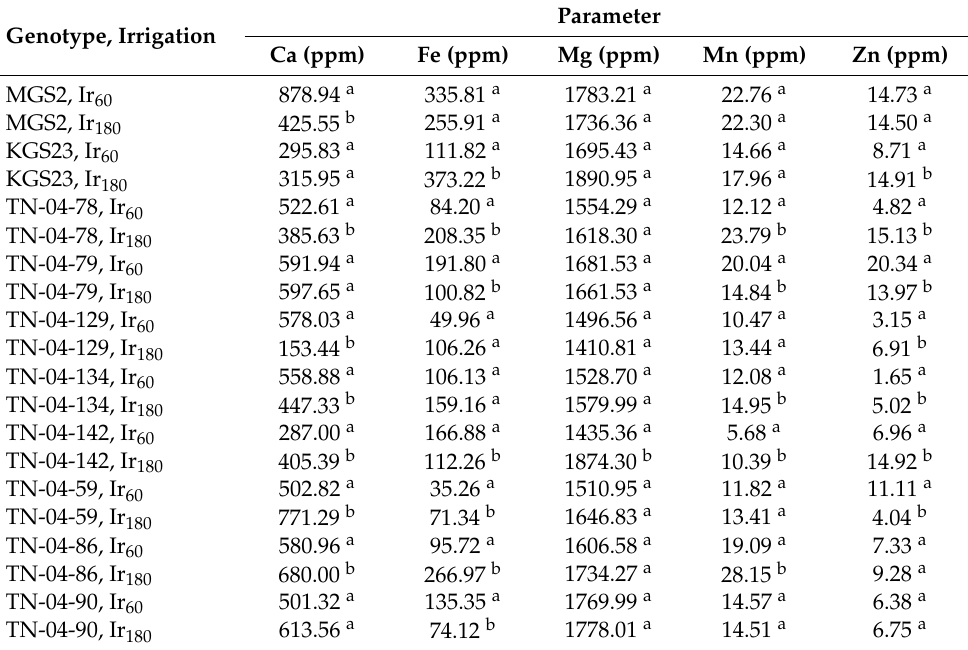
Table 1. Mean values of micronutrients of sorghum grain subjected to normal irrigation and severe deficit